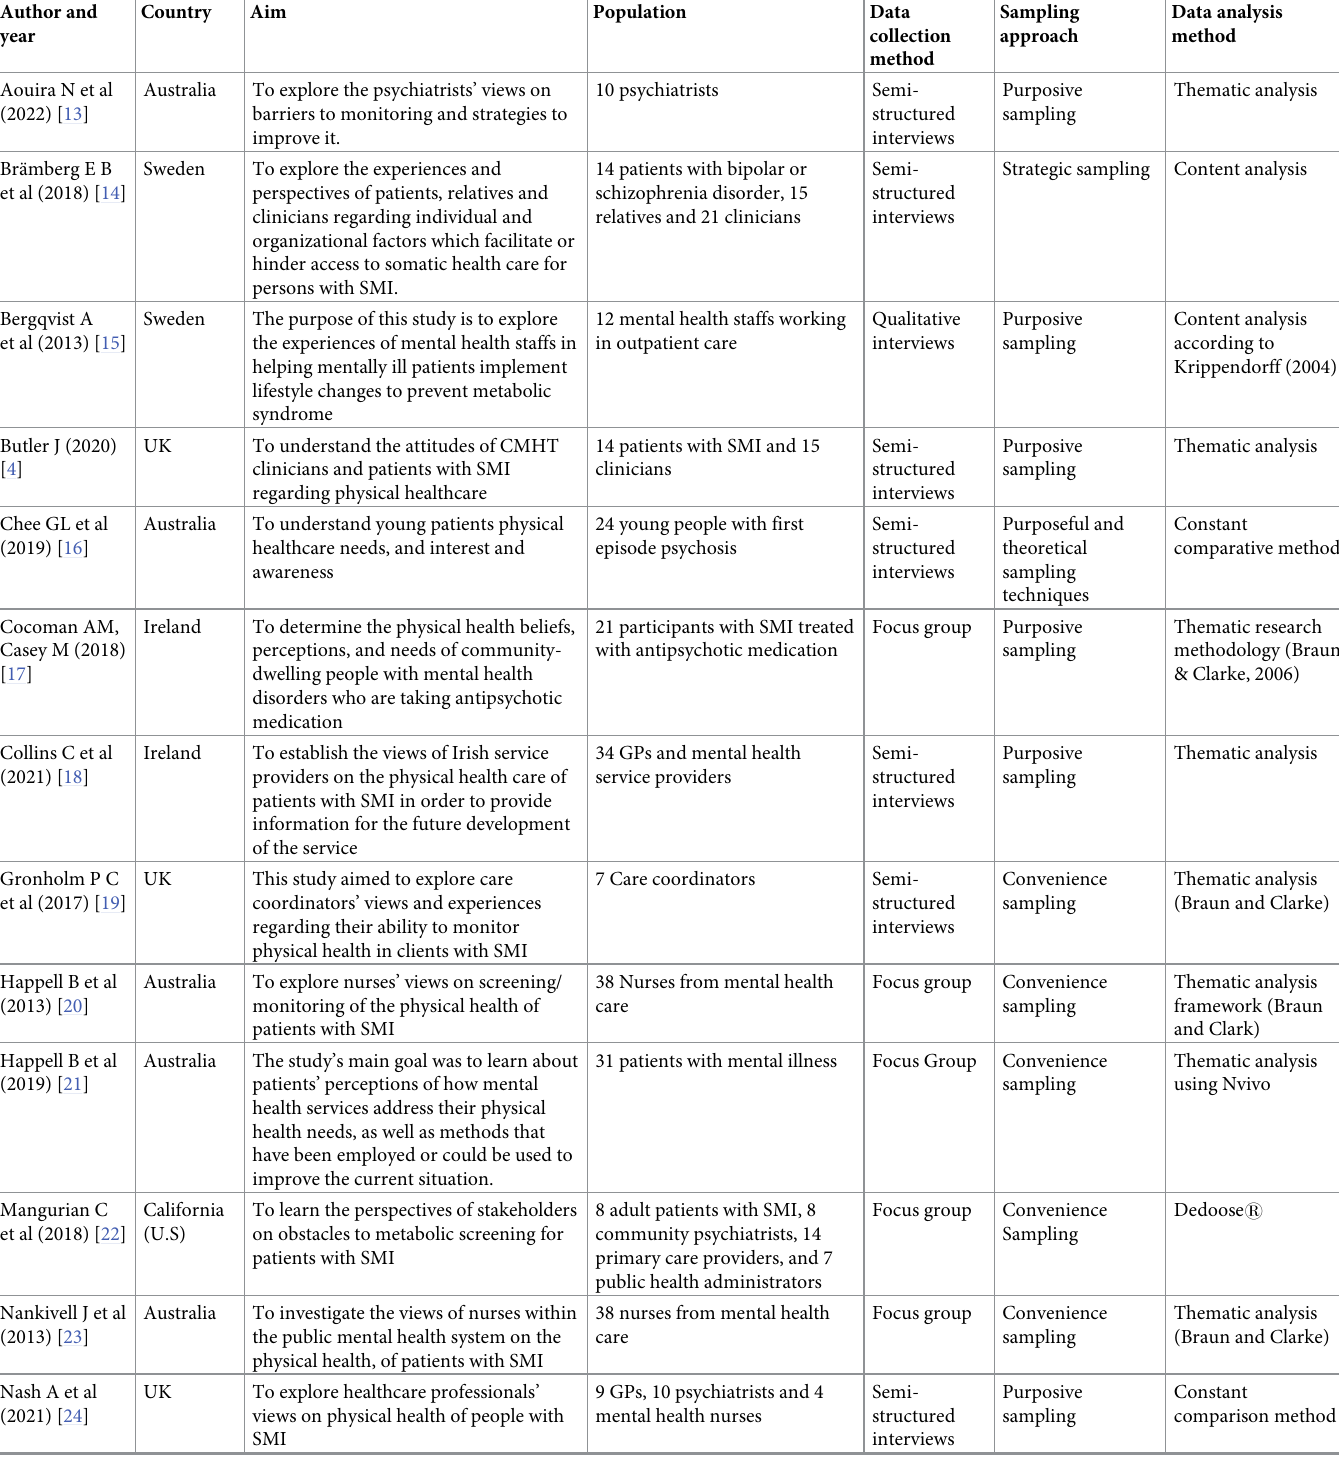
Table 1. Characteristics of the